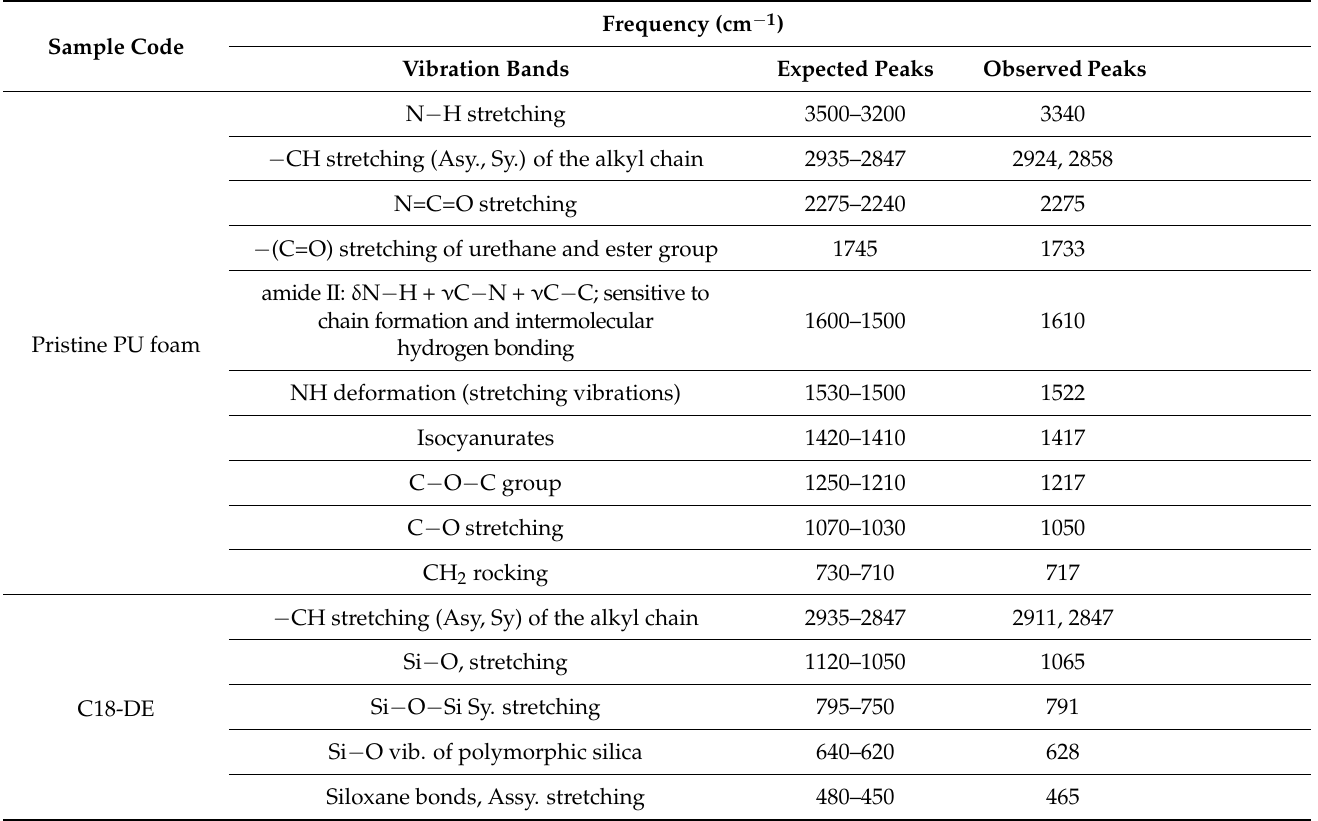
Figure 4. FTIR spectrum represents the structural changes of C18 grafted DE particles and synthesized PU foam before and after modification with C18-DE particles. Table 2. Significant peaks at FTIR spectra of pristine PU foam, C18-DE particles and PU-C18-DE foam.